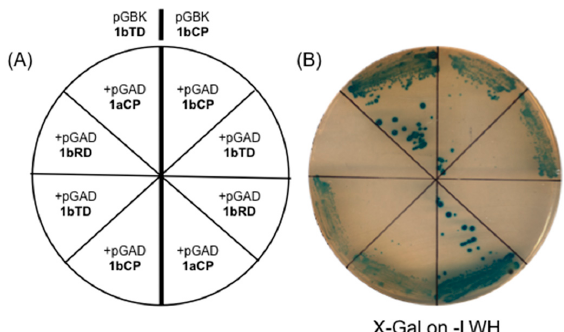
Figure 2. Homodimerization and heterodimerization of HK1b. ( A ) Two-hybrid interaction tests: HK1b-CP and HK1b-TD were tested with different domains of HK1b and HK1a as indicated (CP: cytoplasmic part, TD: transmitter domain, RD: receiver domain); ( B ) Transformed yeasts were streaked onto selective medium (-LWH) for the growth test and X-Gal test.